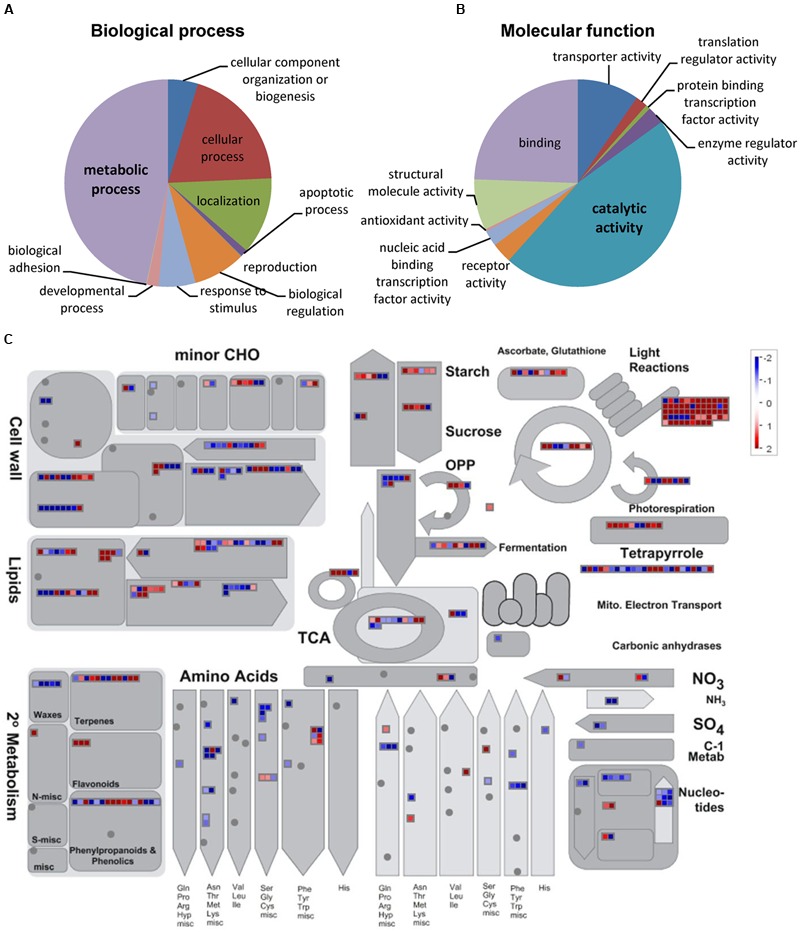
Functional classification of DEGs between IL4-4 and M82. Distribution of GO terms for biological process (A) and molecular function (B) conducted with the PANTHER web tool. (C) Overview of the effect of IL4-4 regulated expression changes on metabolism of fruits with MapMan software (Metabolism_overview panel). MapMan functional categories and Log2 fold change values are represented. Significantly increased and decreased transcripts are shown in red and blue, respectively. A dot represents the log2 of the RPKM ratio of a transcript between IL4-4 and control M82.